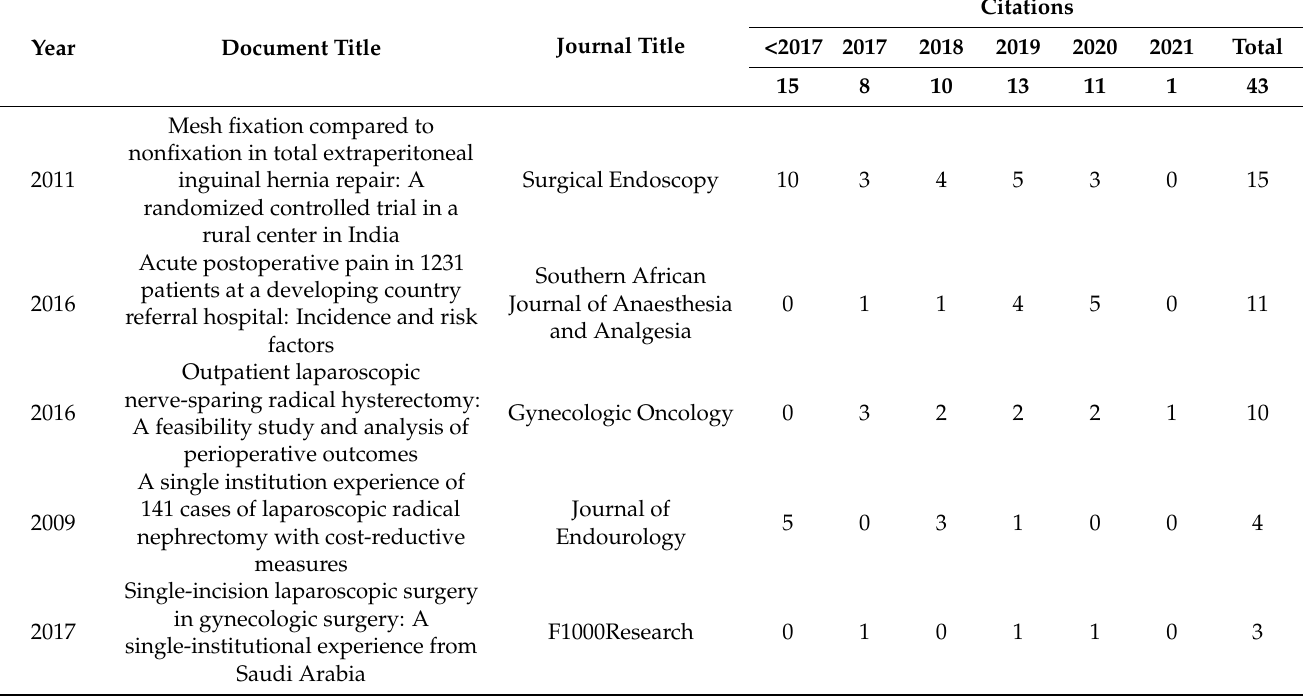
Table 2. Number of citations from top 5 studies over the years.